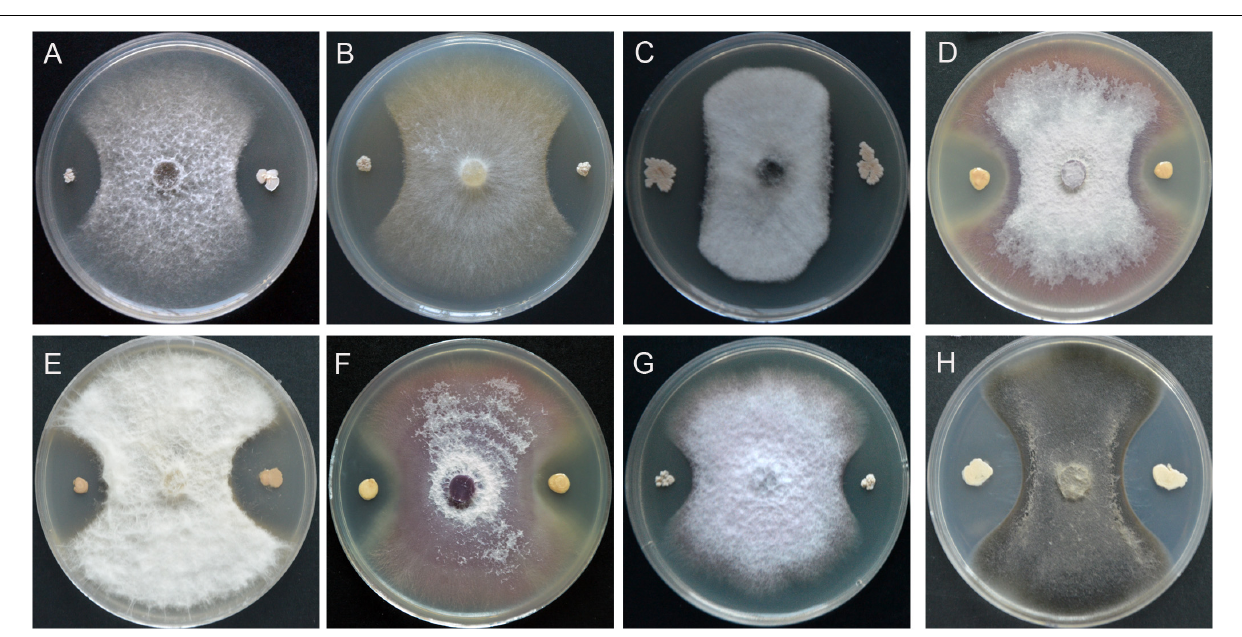
FIGURE 1 | Colony morphology of F. graminearum co-cultivated with strain YB-130 showing upper (A) and lower (B) surface on PDA. Spore morphology of F. graminearum co-cultivated with (D) or without (C) strain YB-130. Hyphal morphology of F. graminearum co-cultivated with (F) or without (E) strain YB-130.